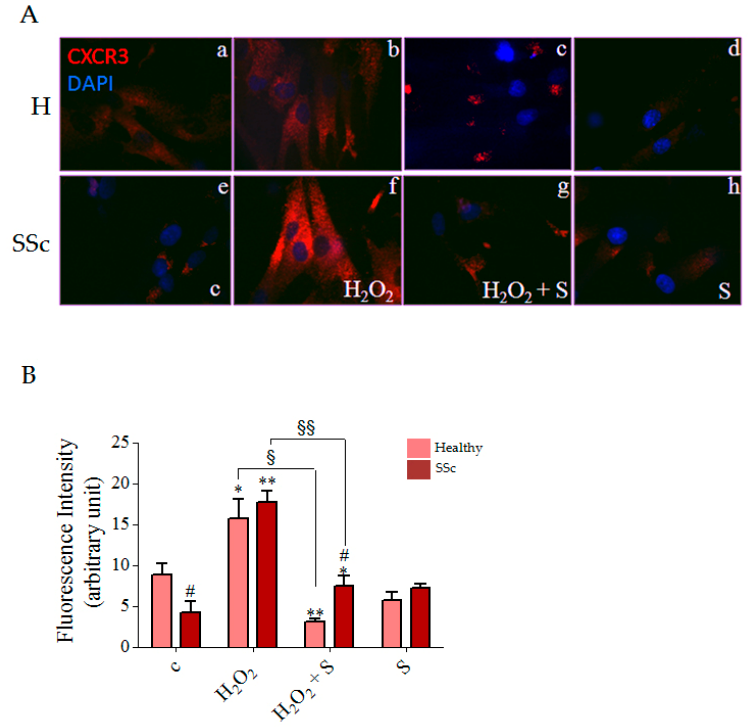
Figure 4. ( A ) Healthy (H) (upper panels) and SSc (lower panels) fibroblasts were exposed to H 2 O 2 (100 µ M, 1 h) in the presence or absence of sildenafil (1 µ M) pre-treatment. Fixed non-permeabilized cells were stained for CXCR3 antibody (red) and DAPI for nuclei (blue). ( B ) Histograms represent the fluorescence intensities of healthy (red columns) and SSc (pink columns) fibroblasts for CXCR3 in the plasma membrane. Statistical significance was determined using ANOVA with Bonferroni’s post-hoc test. * p < 0.05 and ** p < 0.01 vs. relative control within group; # p < 0.05 vs. H 2 O 2; § p < 0.05 and §§ p < 0.01 vs. corresponding treatment between groups; c , control group; S , sildenafil. Experiments were repeated at least three times ( n = 3) with essentially identical results.